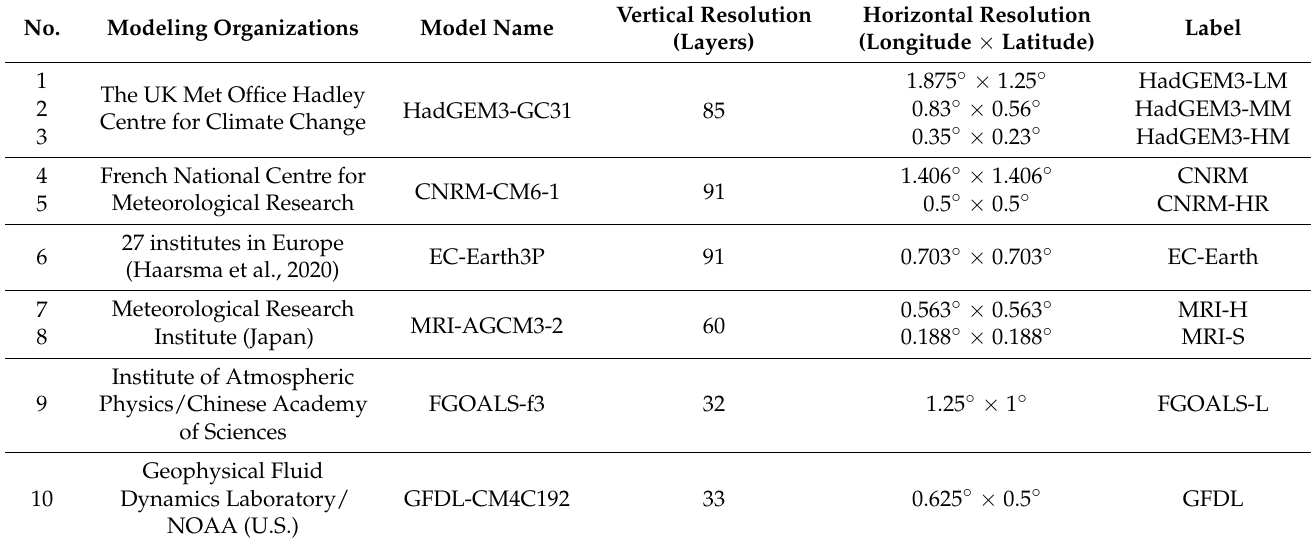
Table 1. Summary of the GCMs used in the CMIP6 HighResMIP experiments.